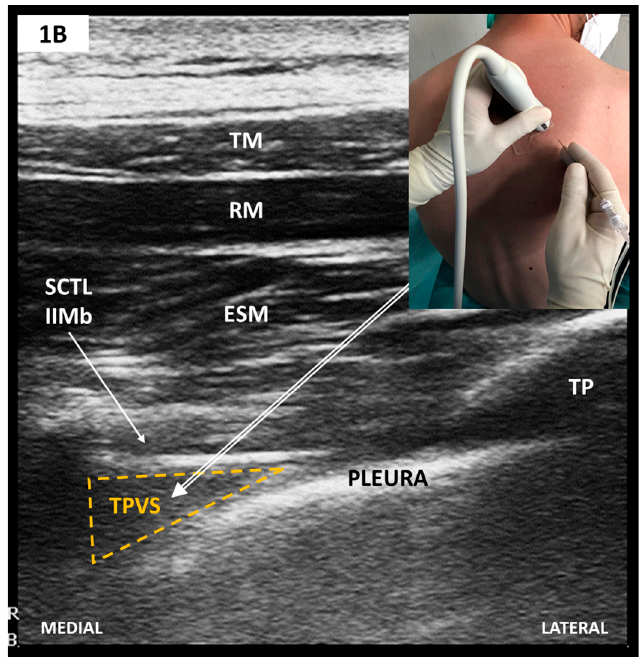
Figure 1. ( A ) . Parasagittal scan of thoracic paravertebral space (TPVS); ( B ) . Transverse/oblique scan of TPVS after 75-degree anti-clockwise rotation from A. The needle tip’s target is TPVS, which, after probe rotation, appears enlarged and lies anteriorly to superior costotransverse ligament (SCTL)/IIMb (see text).TM, trapezius muscle; RM, rhomboid muscle; ESM, erector spinae muscle; EIM, external intercostal muscle; IIM, internal intercostal muscle; TP, transverse vertebral process; SCTL, superior costotransverse ligament; IIMb, internal intercostal membrane; TPVS, thoracic paravertebral space.